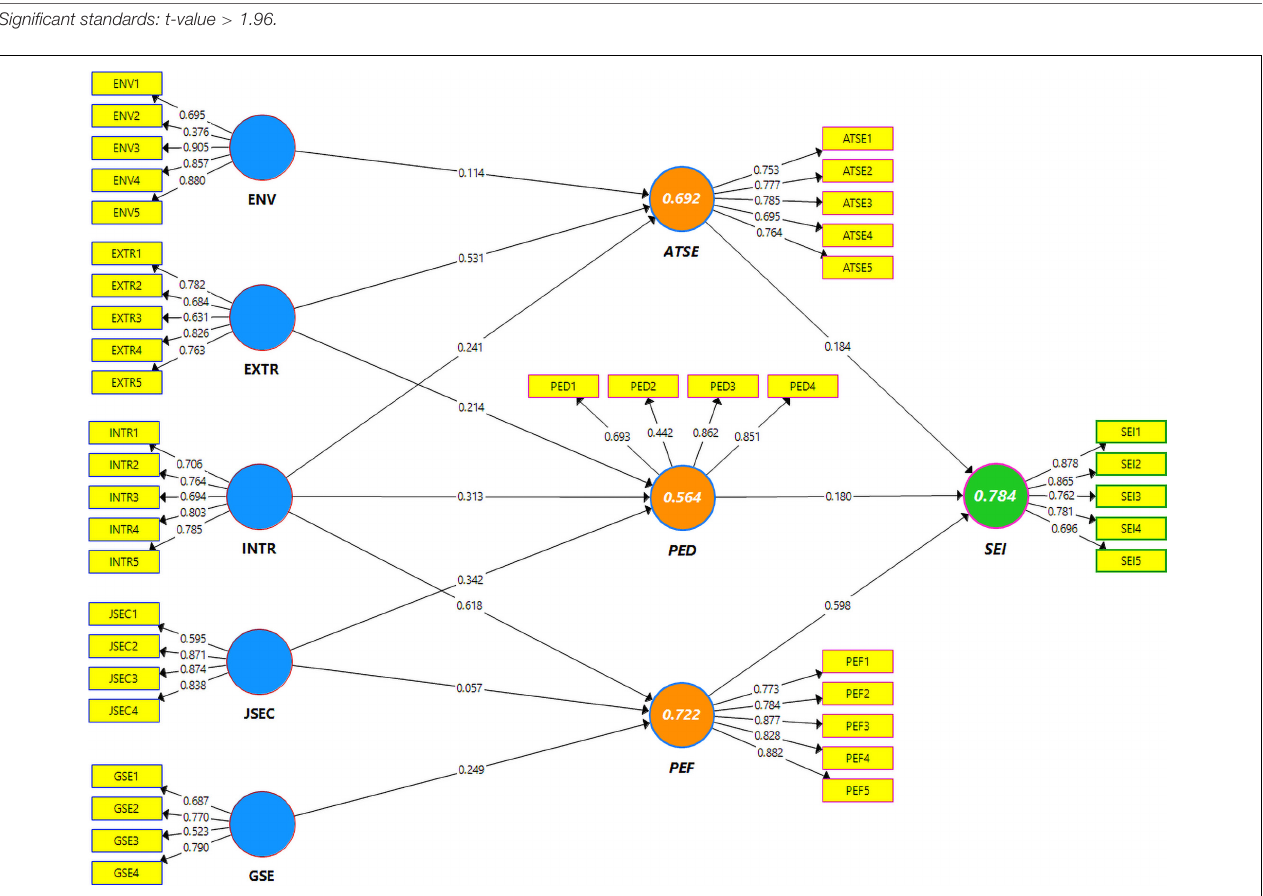
FIGURE 3 | Path coefficients and factor loadings of total sample